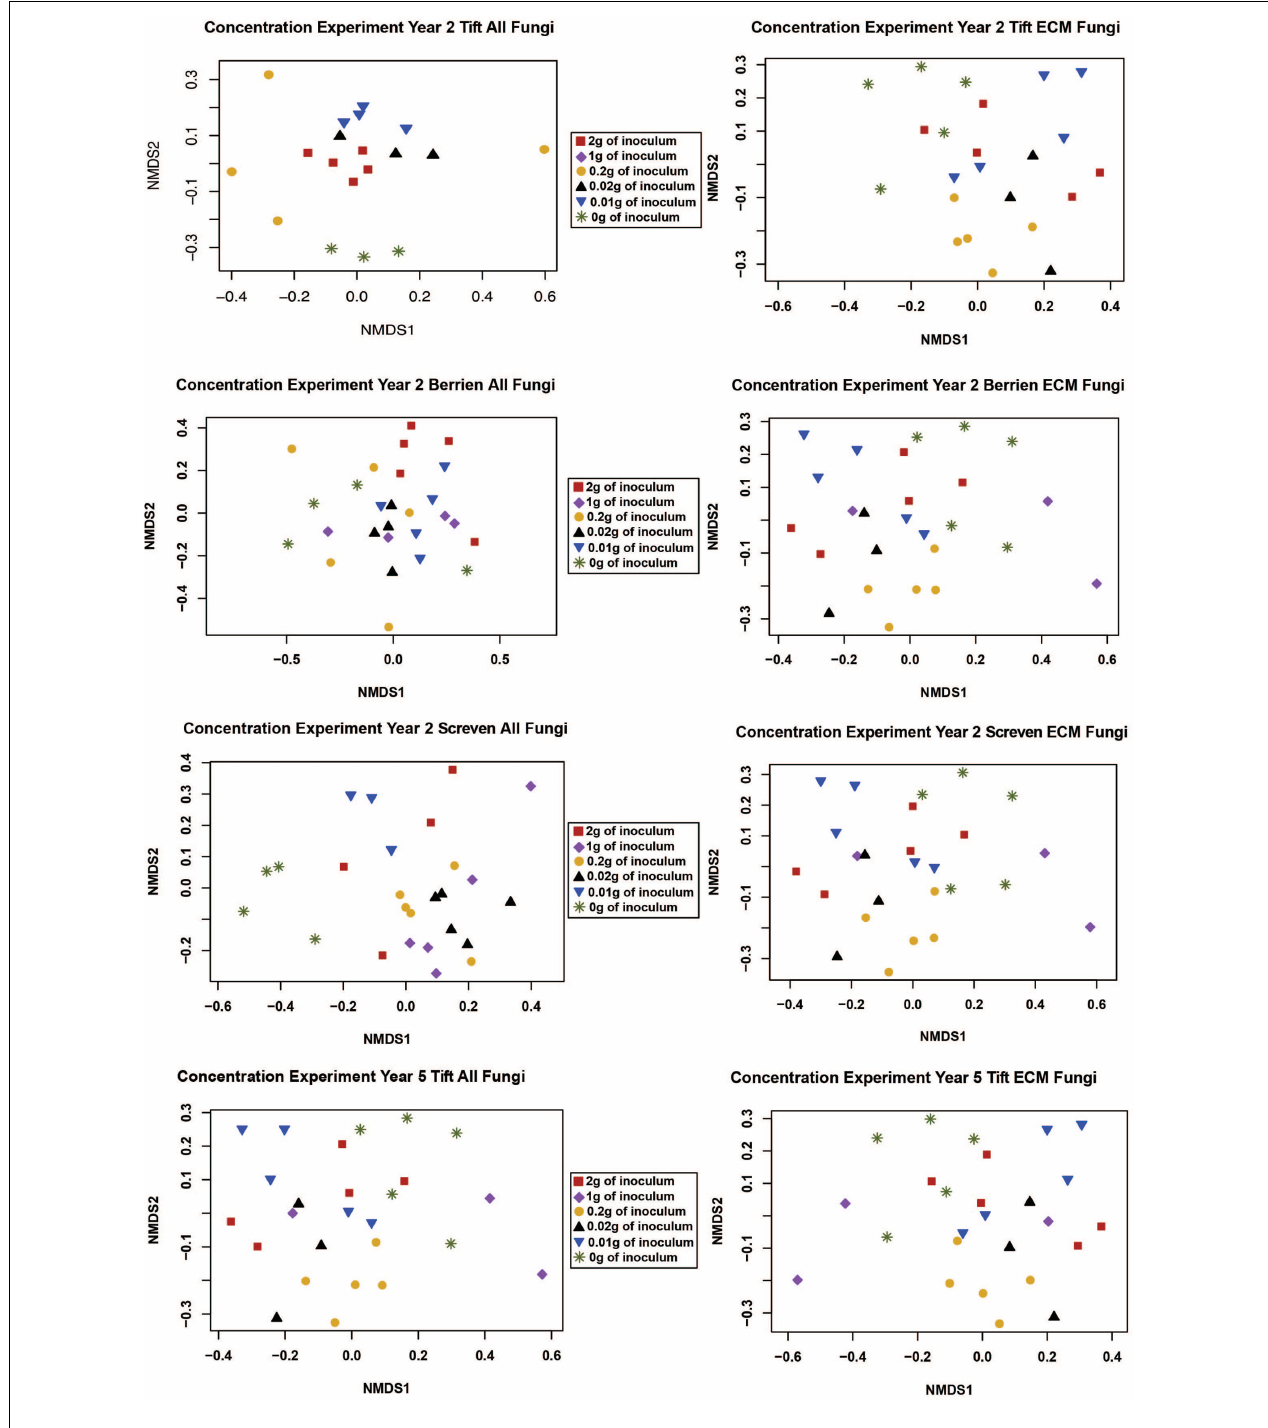
FIGURE 1 | NMDS ordination for the concentration experiment with both the “all fungi” and “ECM fungi only” datasets using the Raup-Crick distance metric, stress < 0.2, and 2–3 dimensions. The only sample for the 1 g treatment at Tift was removed from the ordination because it was an extreme outlier.